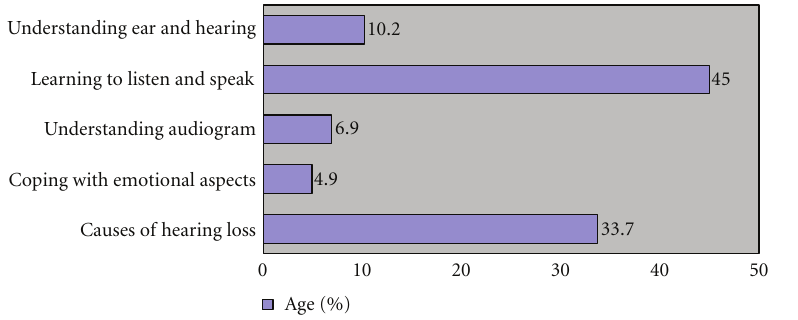
Figure 1: Depicting the queries put forth by group I mothers.